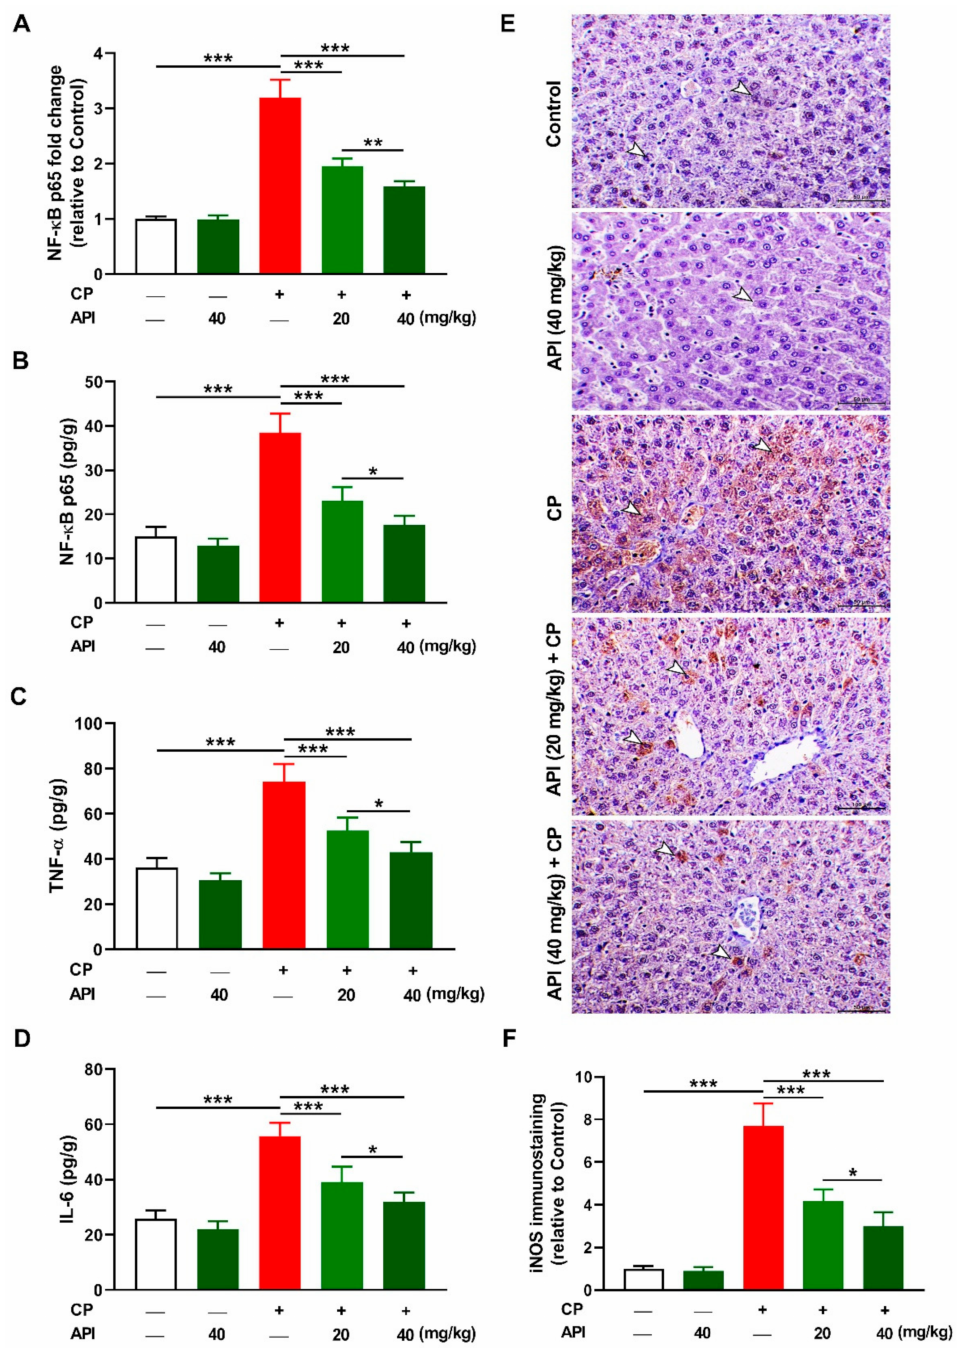
Figure 7. API mitigated inflammation in CP-intoxicated rats. API decreased hepatic ( A ) NF- κ B p65 mRNA, ( B ) NF- κ B p65 protein, ( C ) TNF- α , and ( D ) IL-6 in CP-administered rats. ( E , F ) Photomicro- graphs showing increased immunostaining of iNOS ( E ) and image analysis ( F ) showing that API decreased hepatic iNOS in CP-administered rats. Data are mean ± SEM, ( n = 6). * p < 0.05, ** p < 0.01, and *** p <